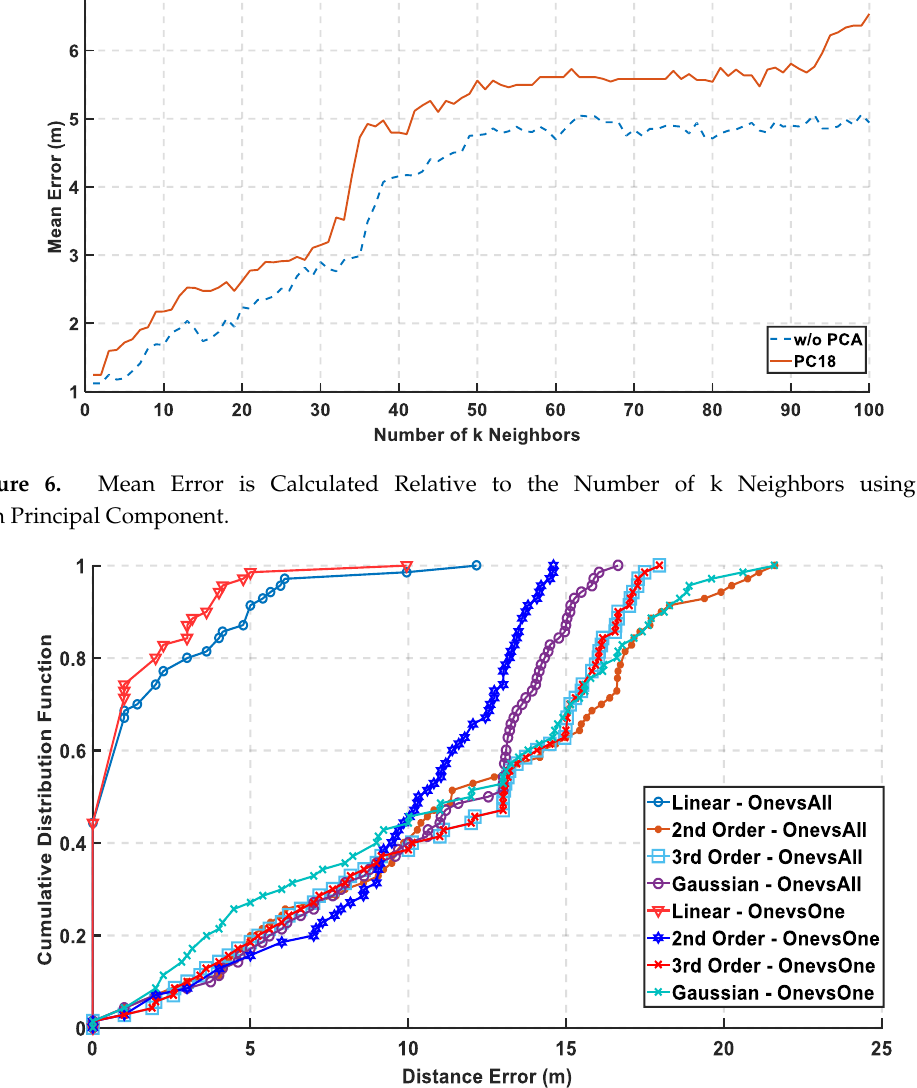
Figure 7. Cumulative Distribution Function using One-Versus-One and One-Versus-All Approaches for Support Vector Machine (SVM) without Principal Component Analysis (PCA).